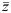
Schematic of method to obtain molecular variables.Reaching position zreach was defined as the minimum value of z¯ that the molecule had reached; staying time tstay was defined as the time that the molecule had stayed in the region on the liquid-phase side of the vapor boundary; ξin and ξout were molecular velocities along the z-direction when the molecule passed through the vapor boundary toward the liquid phase and vapor phase, respectively.